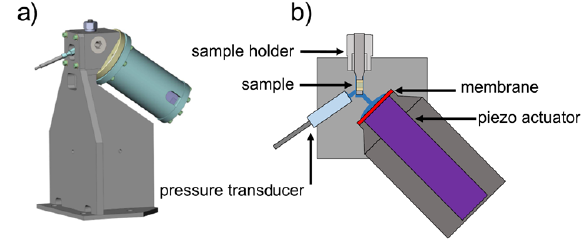
Figure 10: (a) Pressure cell mounted on the setup holder with the piezo-actuator attached; (b) Sketch of the cross section of the cell with the sample holder mounted from the top, the pressure transducer mounted from one side, and the piezo-actuator with the flexible membrane (red) mounted from the other side [73] transition [34–36]. In situ SAXS and wide angle x-ray scat- tering (WAXS) are usually combined to monitor the struc- tural changes at lattice scale and nanoscale,